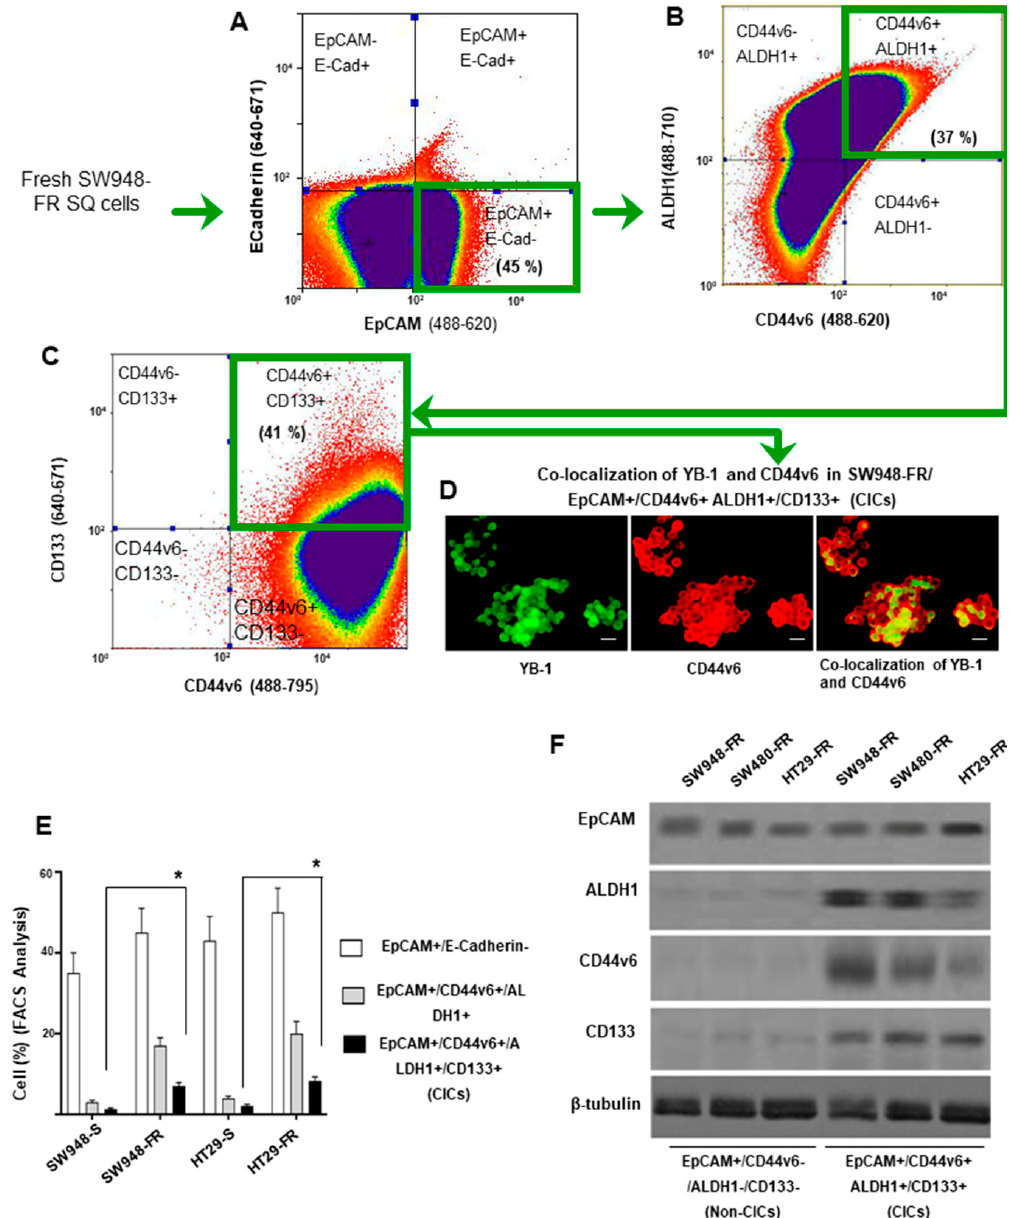
Figure 2. Flow cytometric analyses of EpCAM+/CD44v6+/ALDH+/CD133+ cells in SW948-FR cells isolated from SW948-FR/subcutaneous (SQ) tumors. Alexa fluor-tagged antibodies at the indicated laser lines were used to isolate: ( A ) EpCAM+/ECadherin- cells; ( B ) CD44v6+/ALDH1+ cells from EpCAM+/ECadherin-cells; ( C ) CD133+ cells from CD44v6+/ALDH1+ cells. ( D ) Immunofluorescence staining shows colocalization of CD44v6 (Red) and YB-1 (Green) in EpCAM+/CD44v6+/ALDH1+/CD133+ (CICs), scale bar, 50 µm. ( E ) Percentages of EpCAM+/E-cadherin-, CD44v6+/ALDH1+, and CD44v6+/ALDH1+/CD133+ on sorted cells were assessed by flow cytometry on freshly purified CRC cells isolated from subcutaneous (SQ) SW948-FR tumor cells. ( F ) Western blots are shown for EpCAM+/CD44v6-/ALDH-/CD133- (Non-CICs) and EpCAM+/CD44v6+/ALDH+/CD133+ (CICs) by probing with E-Cadherin, EpCAM, CD44v6, ALDH1, YB-1, and CD133 antibodies. FACS, immunofluorescence and WB data are representative of three experiments. Enrichment of CICs in FR cells compared to sensitive pairs in Figure 2E are presented as mean ± SD ( n = 3); *, p < 0.01. Student’s t test was used to assess the significance. The experiment was performed three times and representative data are shown.